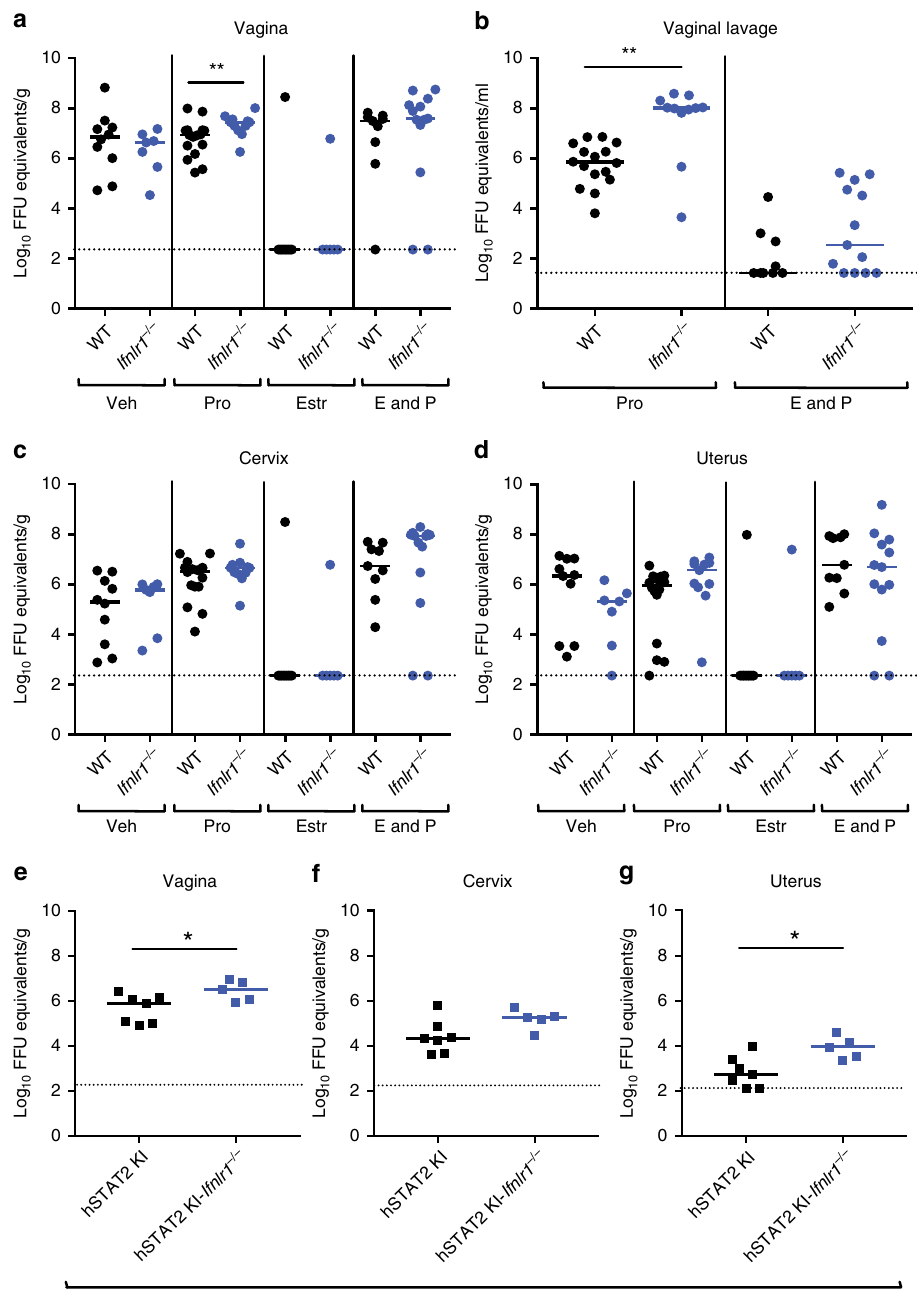
Fig. 3 Hormone treatment modulates the severity of ZIKV infection in the vagina of OVX Ifnlr1 − / − and hSTAT2 KI Ifnlr1 − / − mice. Six-week-old WT, Ifnlr1 − / − , hSTAT2 KI, or hSTAT2 KI Ifnlr1 − / − OVX mice were given a hormone replacement regimen of estradiol, progesterone, estradiol and progesterone, or vehicle. WT and Ifnlr1 − / − mice were treated with 1 mg of anti-Ifnar1 mAb at day − 1. On day 0, mice were inoculated via intravaginal route with 10 6 FFU of ZIKV (Dakar 41525). At 3 dpi, vaginal lavage was performed ( b ). At 7 dpi, ZIKV RNA was measured from the vagina ( a , e ), cervix ( c , f ), and uterus ( d , g ). Dotted lines indicate the LOD. Results are pooled from two or three experiments. Bars indicate median values (Mann – Whitney test: (*, P < 0.05 **, P < 0.01). Numbers of mice: Vehicle: WT + anti-Ifnar1, n = 10; Ifnlr1 − / − + anti-Ifnar1, n = 7. Progesterone: WT + anti-Ifnar1, n = 16; Ifnlr1 − / − + anti-Ifnar1, n = 11; hSTAT2 KI, n = 7; or hSTAT2 KI Ifnlr1 − / − , n = 5. Estradiol: WT + anti-Ifnar1, n = 10; Ifnlr1 − / − + anti-Ifnar1, n = 6. Estradiol and progesterone: WT + anti- Ifnar1, n = 9; Ifnlr1 − / − + anti-Ifnar1, n =